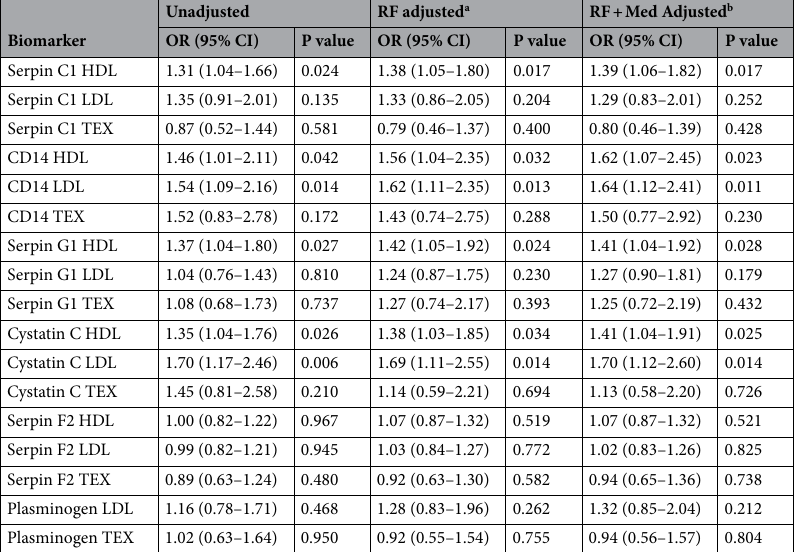
Table 2. Logistic regression analysis for stress-induced myocardial ischemia. Biomarker levels are log- transformed and standardized per synthetic vesicle and shown as mean ± SD. Original assay units are pg/ml. RF Risk factor, Med medication. a RF adjusted; age, sex, hypertension, hypercholesterolemia, smoking, diabetes mellitus and coronary artery disease. b RF + Med adjusted: platelet inhibitors and blood pressure lowering